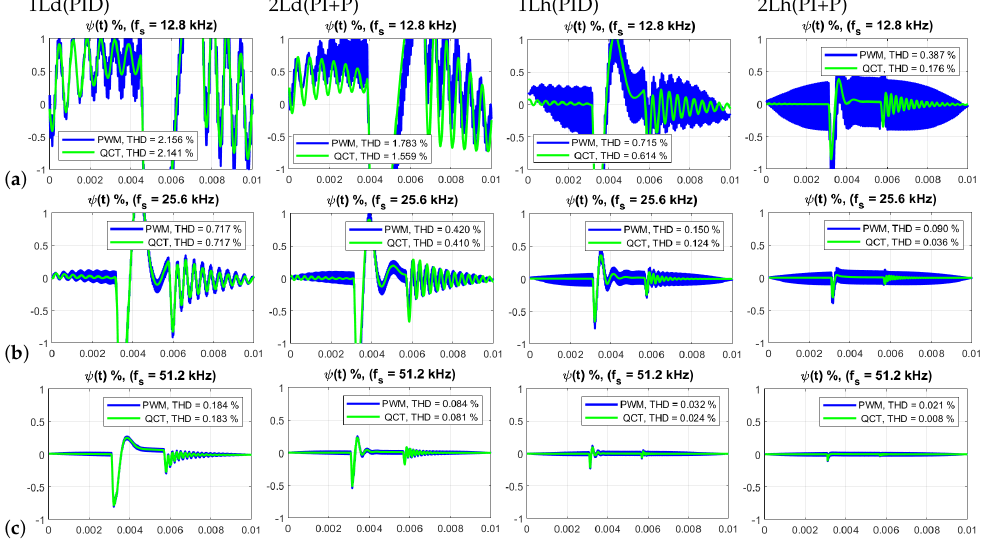
Figure 18. Distortion function ψ ( t ) and THD values of v out ( t ) in 1L (PID) and 2L (PI+P) control systems optimized for the RC rectifier load operating at different carrier frequencies f s : ( a ) 12.8 kHz, ( b ) 25.6 kHz, and ( c ) 51.2 kHz. All plots are displayed in the same scale. Plots in ( a ) extending beyond the display window are also displayed in the appropriate scale in Figure 25.